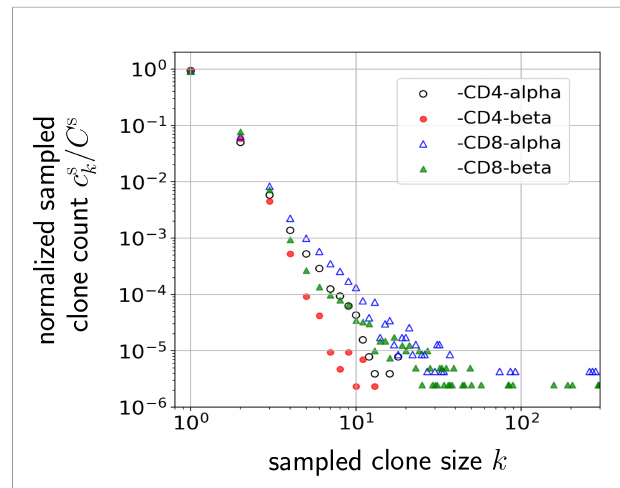
FIGURE 1 | Normalized naive T cell clone count data from one patient in Oakes et al. (12) plotted on a log-log scale. Values of the normalized clone counts along the vertical axis are the average of three samples among CD4 and CD8 cell subgroups. Clones are de fi ned by different nucleotide sequences associated with different alpha or beta chains of the